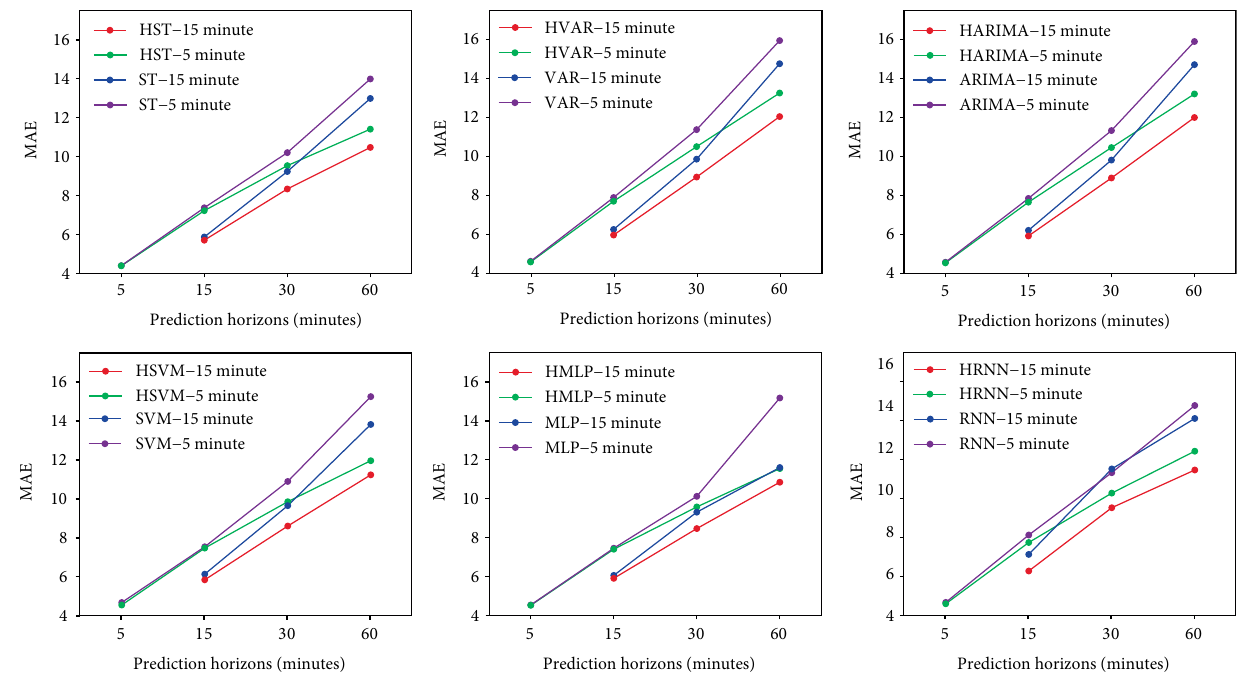
Figure 6: The MAE values of models for different horizons and aggregation levels in peak hours on station